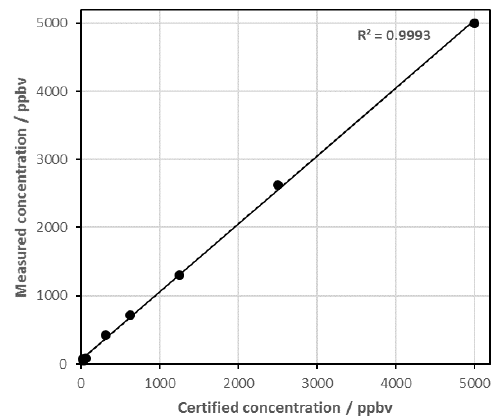
Figure 4. Comparison of SIFT-MS measurement against various concentrations of Vikane obtained by static dilutions of a certified 5.02 ppmv Vikane/air mixture.